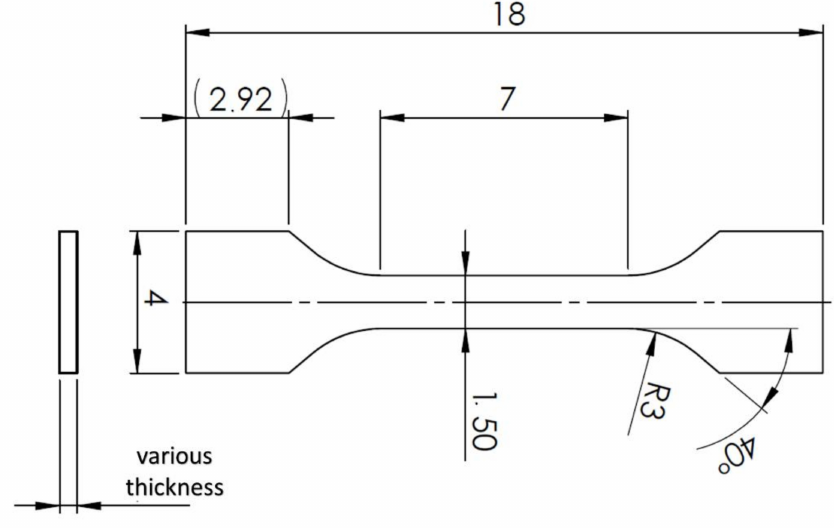
Figure 2. Detailed geometry of flat tensile test specimens (dimensions in